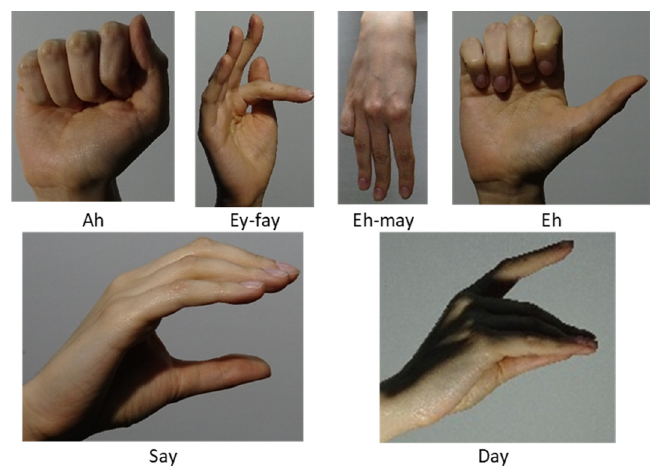
Figure 8. A subset of the Pakistani sign language dataset.